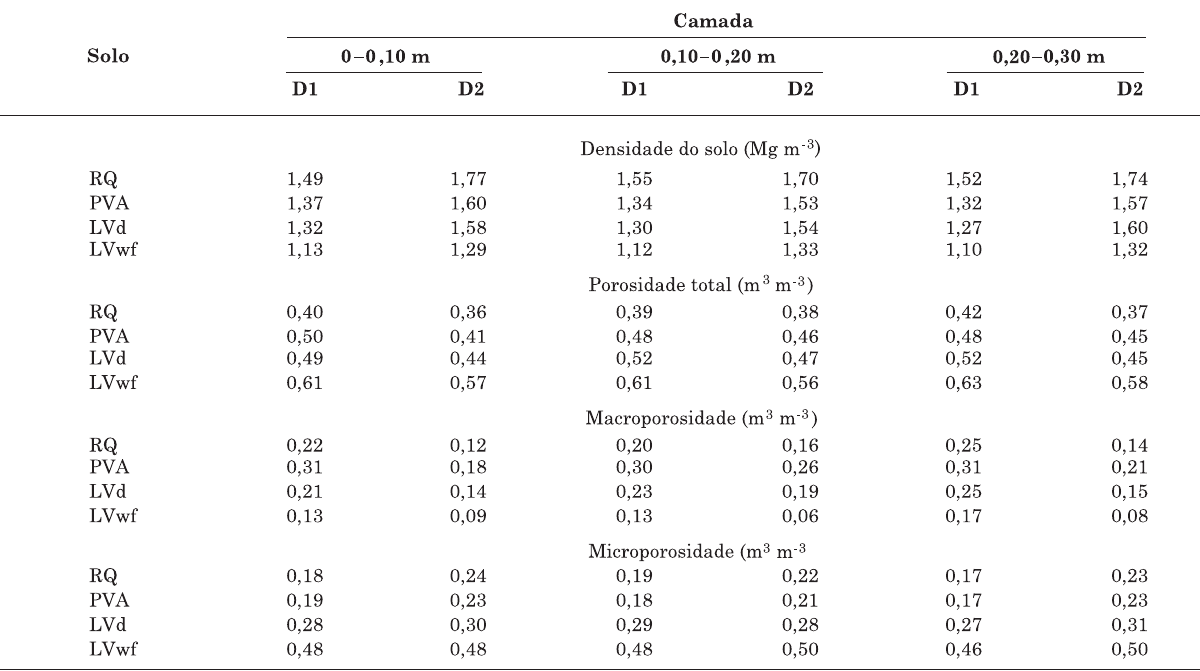
Quadro 2. Densidade, porosidade total, macroporosidade e microporosidade, nas camadas de 0–0,10,